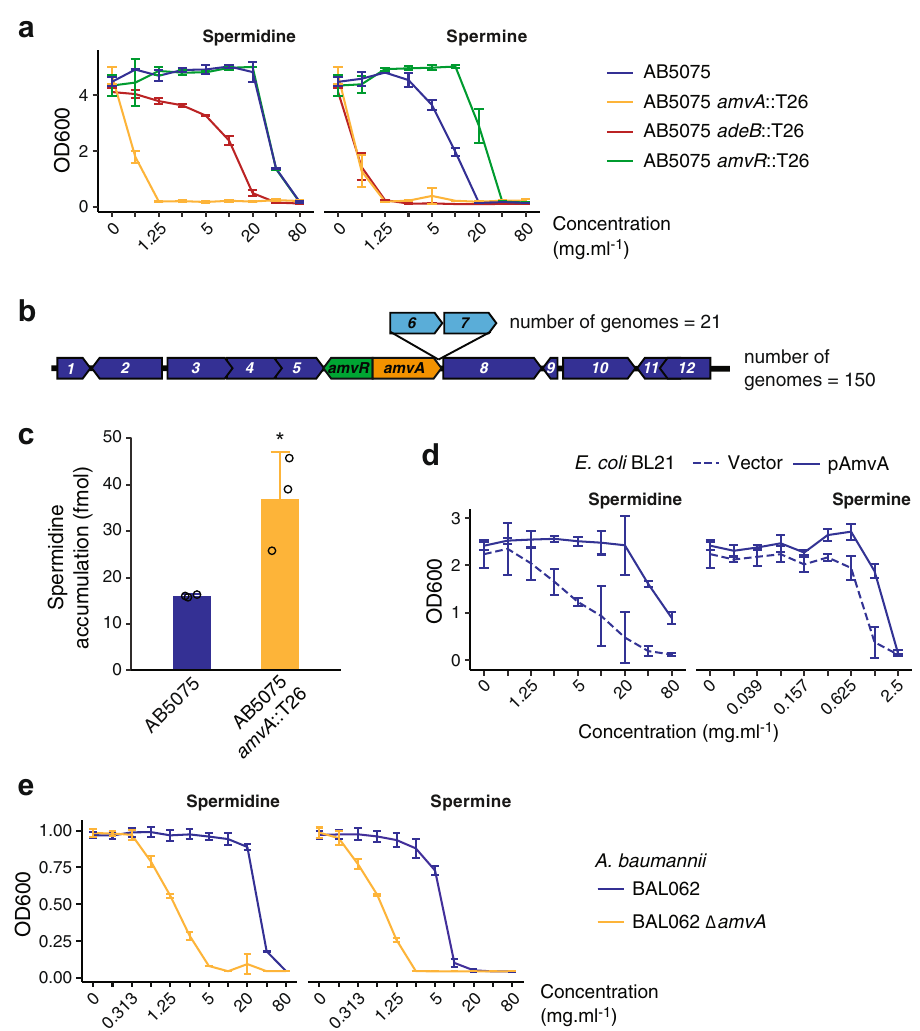
Fig. 3 Induction of ef fl ux pumps by polyamine shock identi fi es spermine and spermidine as AmvA substrates. a Growth of A. baumannii AB5075 and mutants in the presence of spermine and spermidine. Results are mean ± SD for two biological and two technical replicates. b Genomic context of amvAR in 172 A. baumannii strains. The genes are present in 100% of complete A. baumannii genomes in a region of very high synteny. Core genes are shown in dark blue, accessory genes in light blue, and the number of genomes possessing each gene path is indicated. Annotated gene functions are: 1 — aceI PACE family transporter, 2 — acetyl-CoA acyltransferase, 3 — short-chain dehydrogenase/reductase, 4 — MaoC domain protein dehydratase, 5 — beta-lactamase, 6 — hypothetical protein, 7 — hypothetical protein, 8 — dnaX DNA pol III subunit tau, 9 — hypothetical protein, 10 — phospholipase C, 11 — thioesterase family protein, 12 — iron-containing alcohol dehydrogenase. c Intracellular accumulation of 3 H-spermidine in A. baumannii AB5075 and its AB5075:: amvA mutant. Late exponential-phase cells were washed into assay buffer and incubated with 10.8 nM 3 H-spermidine (see ‘ Methods ’ ), and the amount of accumulated radioactivity measured by liquid scintillation counting. Results shown are from three independent biological replicates. * p < 0.05, one-way ANOVA. d Growth of E. coli BL21 in the presence of spermidine and spermine, with or without AmvA overexpression. Results are mean ± SD for three biological and two technical replicates. e Growth of A. baumannii BAL062 and its Δ amvA mutant in the presence of spermidine and spermine. Results are mean ± SD for two biological and two technical